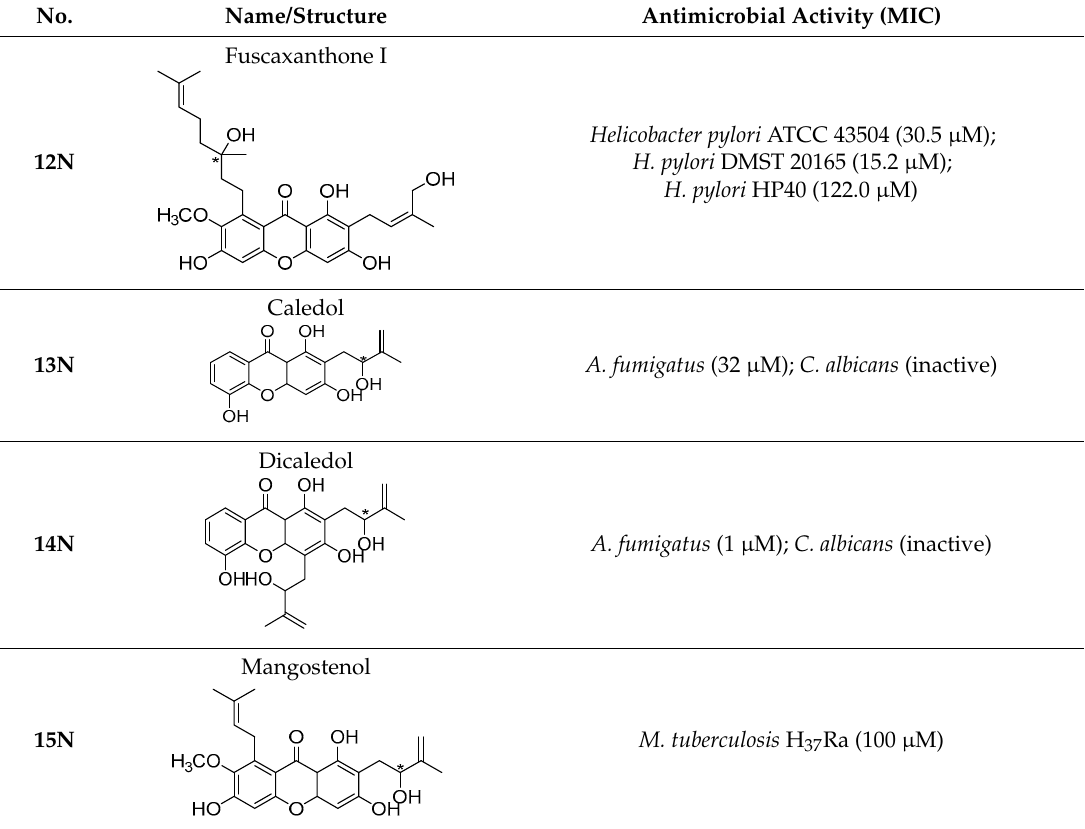
Table 4. Antimicrobial activity of natural caged xanthones: scortechinones and prenylated.